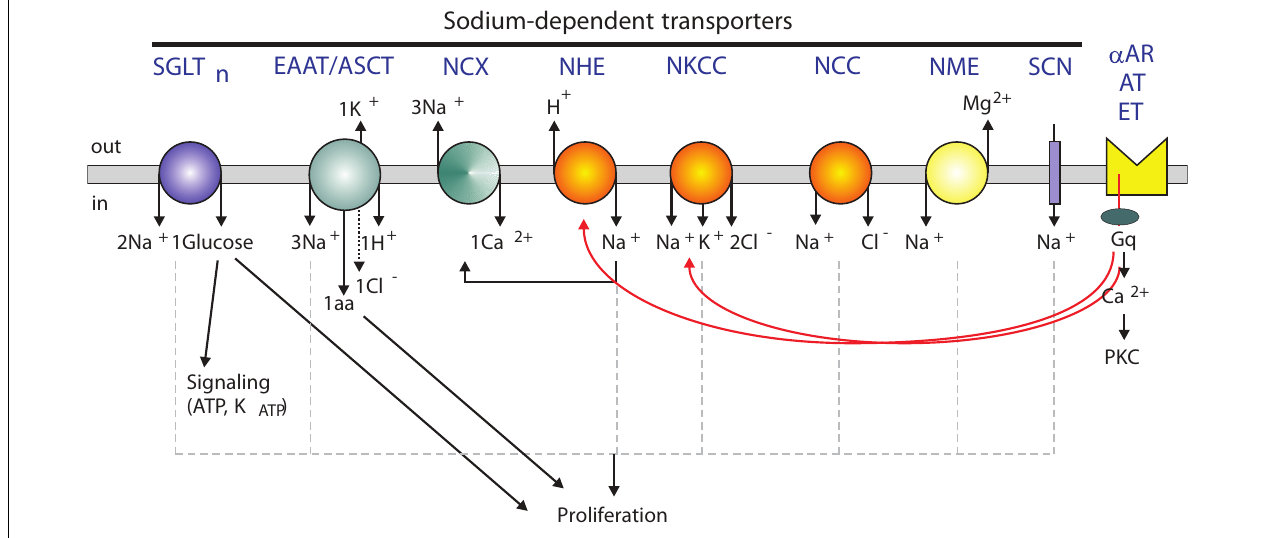
FIGURE 1 | Model showing sodium-dependent transporters and possible signaling roles. Several Na + -dependent solute carriers with their individual stoichiometry of ions, sugars, and amino acids are depicted. SGLT, Na + -dependent glucose cotransporter; EAAT, Na + -dependent excitatory amino acid transporter; NCX, Na + -dependent Ca 2 + exchanger; NHE, Na + -dependent hydrogen exchanger; NKCC, Na + -dependent potassium chloride cotransporter; NCC, Na + -dependent chloride cotransporter; NME, Na + -dependent magnesium exchanger; SCN, Sodium Channel. Transporters are regulated by alpha adrenergic ( α AR), angiotensin II (AT), and endothelin (ET) receptors.